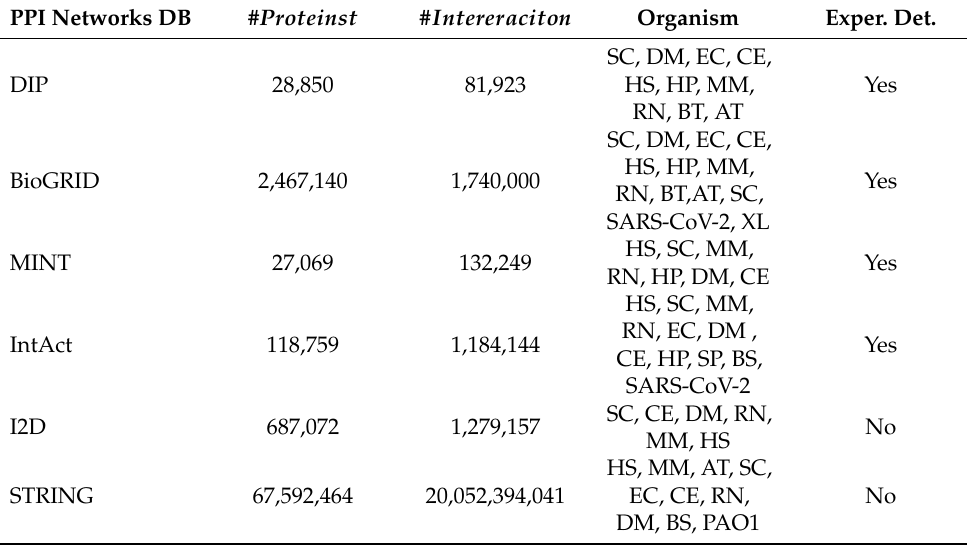
Table 2. The table summarizes the main characteristics of the listed databases. In the table, the col- umn # Proteinst refers to the total number of memorized proteins for each database; the column # Intereraciton refers to the total number of memorized protein interactions for each database; the column Organism is related to the organisms on which the ppi are inferred; the column Exper Det. records whether the interactions have been experimentally